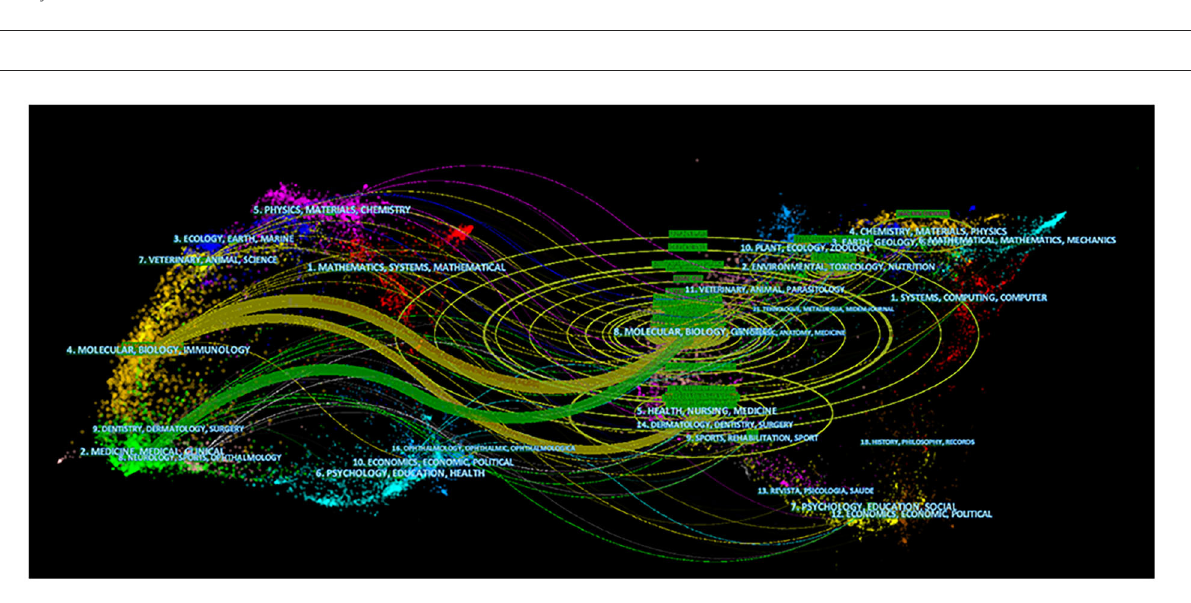
FIGURE8 A dual-map overlay analysis in gut microbiota and host immune response. The left side represents the fields of articles included in the study, and the right side represents the fields of references of